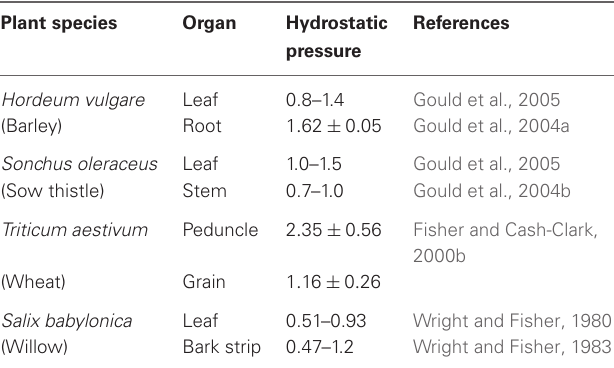
Table 1 | Measures of sieve tube hydrostatic pressures (MPa) using micromanometers glued to severed aphid stylets inserted into translocating sieve tubes, in specified plant organs and